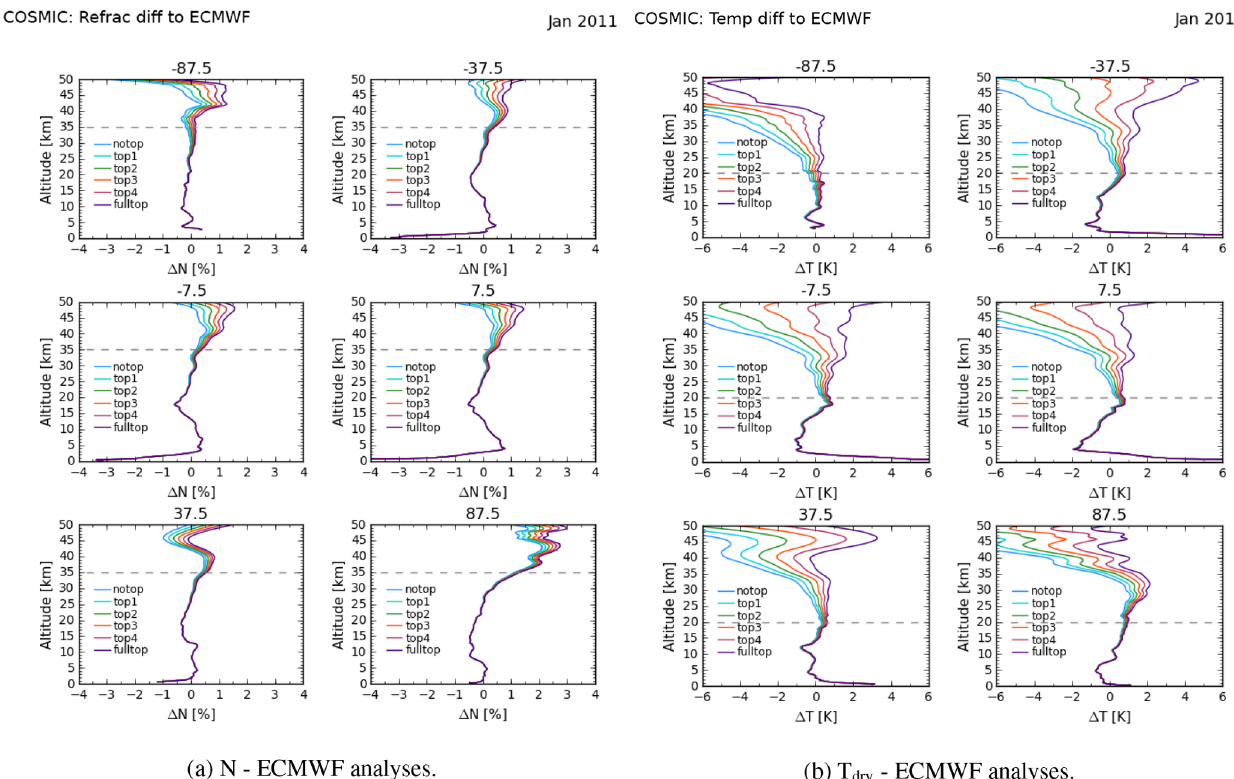
Figure 10. Sensitivity of single climatological profiles relative to different handling of the altitude above 80km, analyzed against ECMWF